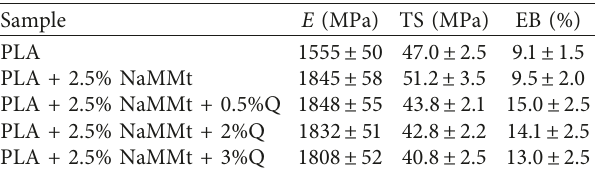
Table 3: Main mechanical properties: elastic modulus ( E ), tensile strength (TS), and elongation at break (EB), of neat PLA and PLA/ NaMMt containing different amounts of